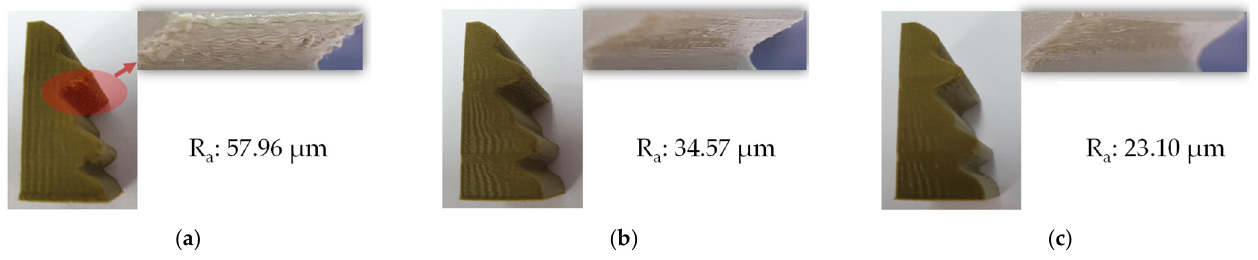
Figure 12. Comparison of fabricated parts: ( a ) Original shape with conventional slicer, ( b ) Original shape with process optimization only (in-house slicer), ( c ) Original model with the proposed approach (in-house slicer).